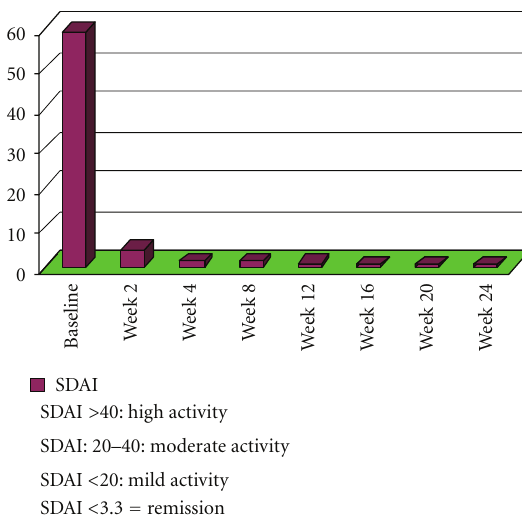
Figure 2: Rheumatoid arthritis activity (SDAI) during treatment with